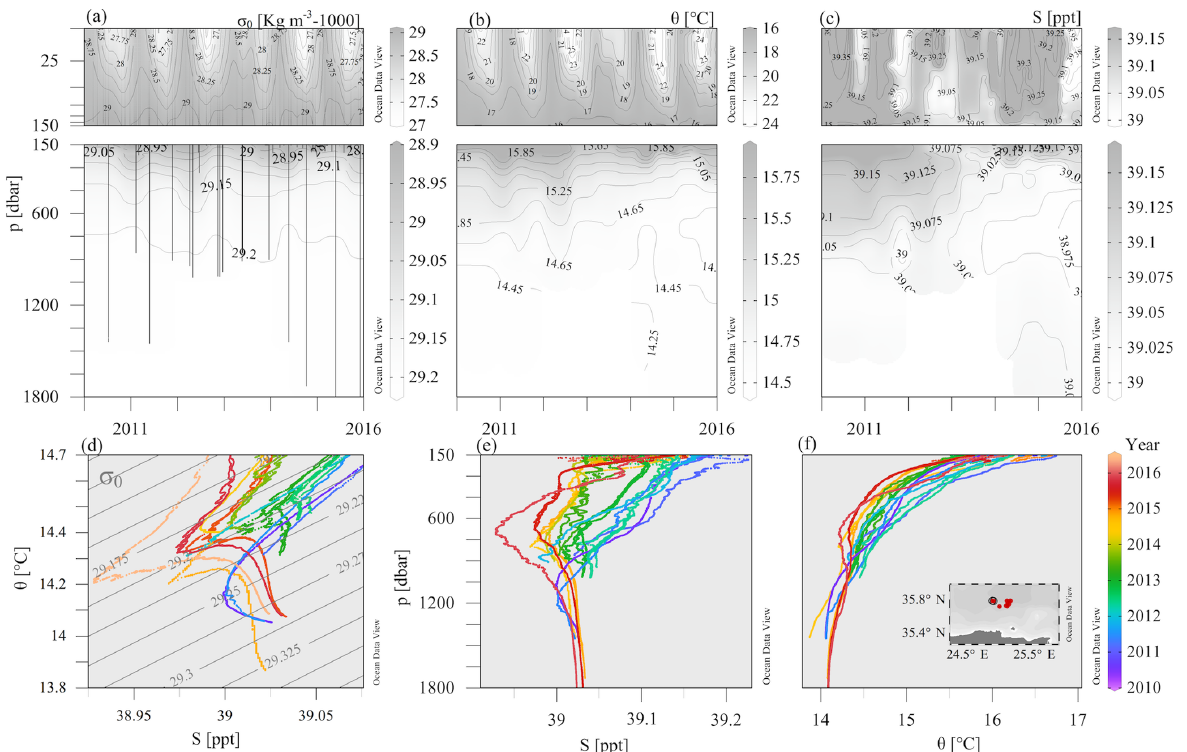
Figure 3. CTD casts collected during monitoring and maintenance visits to the E1-M3A observatory site with HCMR research vessels from 2010 to 2016. Time–depth plots of potential density anomalies ( σ 0 ) (a) , potential temperature ( θ ) (b) and practical salinity ( S ) (c) . θ – S plot (d) and vertical profiles of S (e) and θ (f) are colored according to the date to reveal temporal